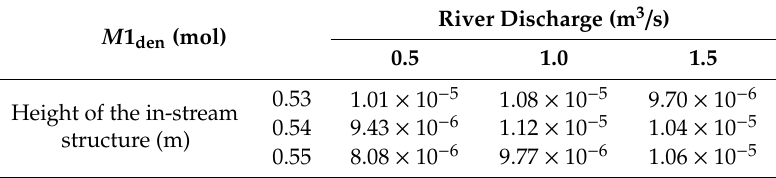
Table 6. The results of sensitivity analysis based on di ff erent river